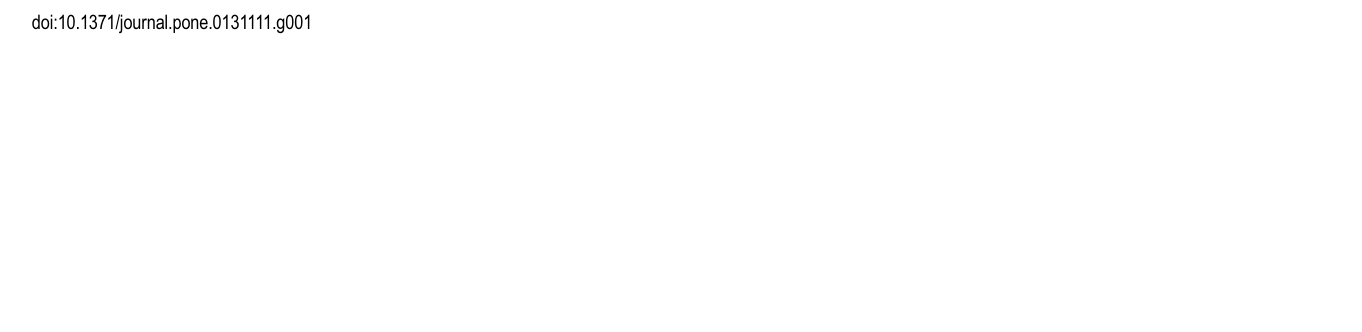
Fig 1. Graph of the ideal cosines. Graph representing the cosine waves: cos ð 2 p line shows the fi rst peak time